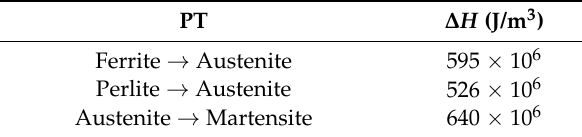
Table 5. Latent heat released during